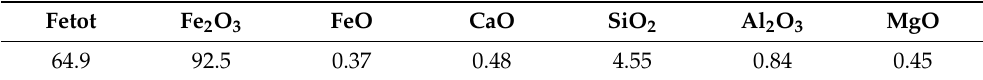
Table 2. Composition of the unreduced ore pellets in wt.%.